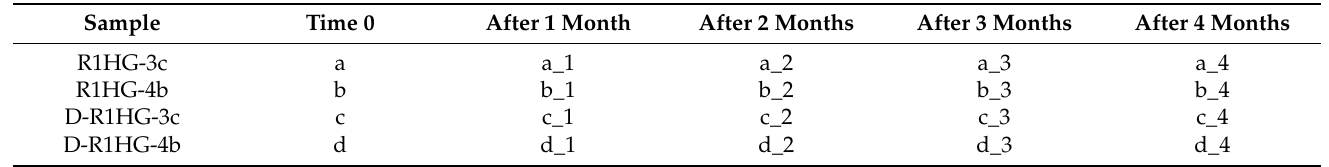
Figure 10. Results by the PCAs performed on the matrix collecting the data of the ATR-FTIR spectra of R1HG-3c (a), R1HG-4b (b), D-R1HG-3c (c), and D-R1HG-4b (d), acquired over time for four months. The results are presented as scores plot of PC1 vs. PC2. Table 4. New name assignations reported in Figure 10 for the samples analyzed by